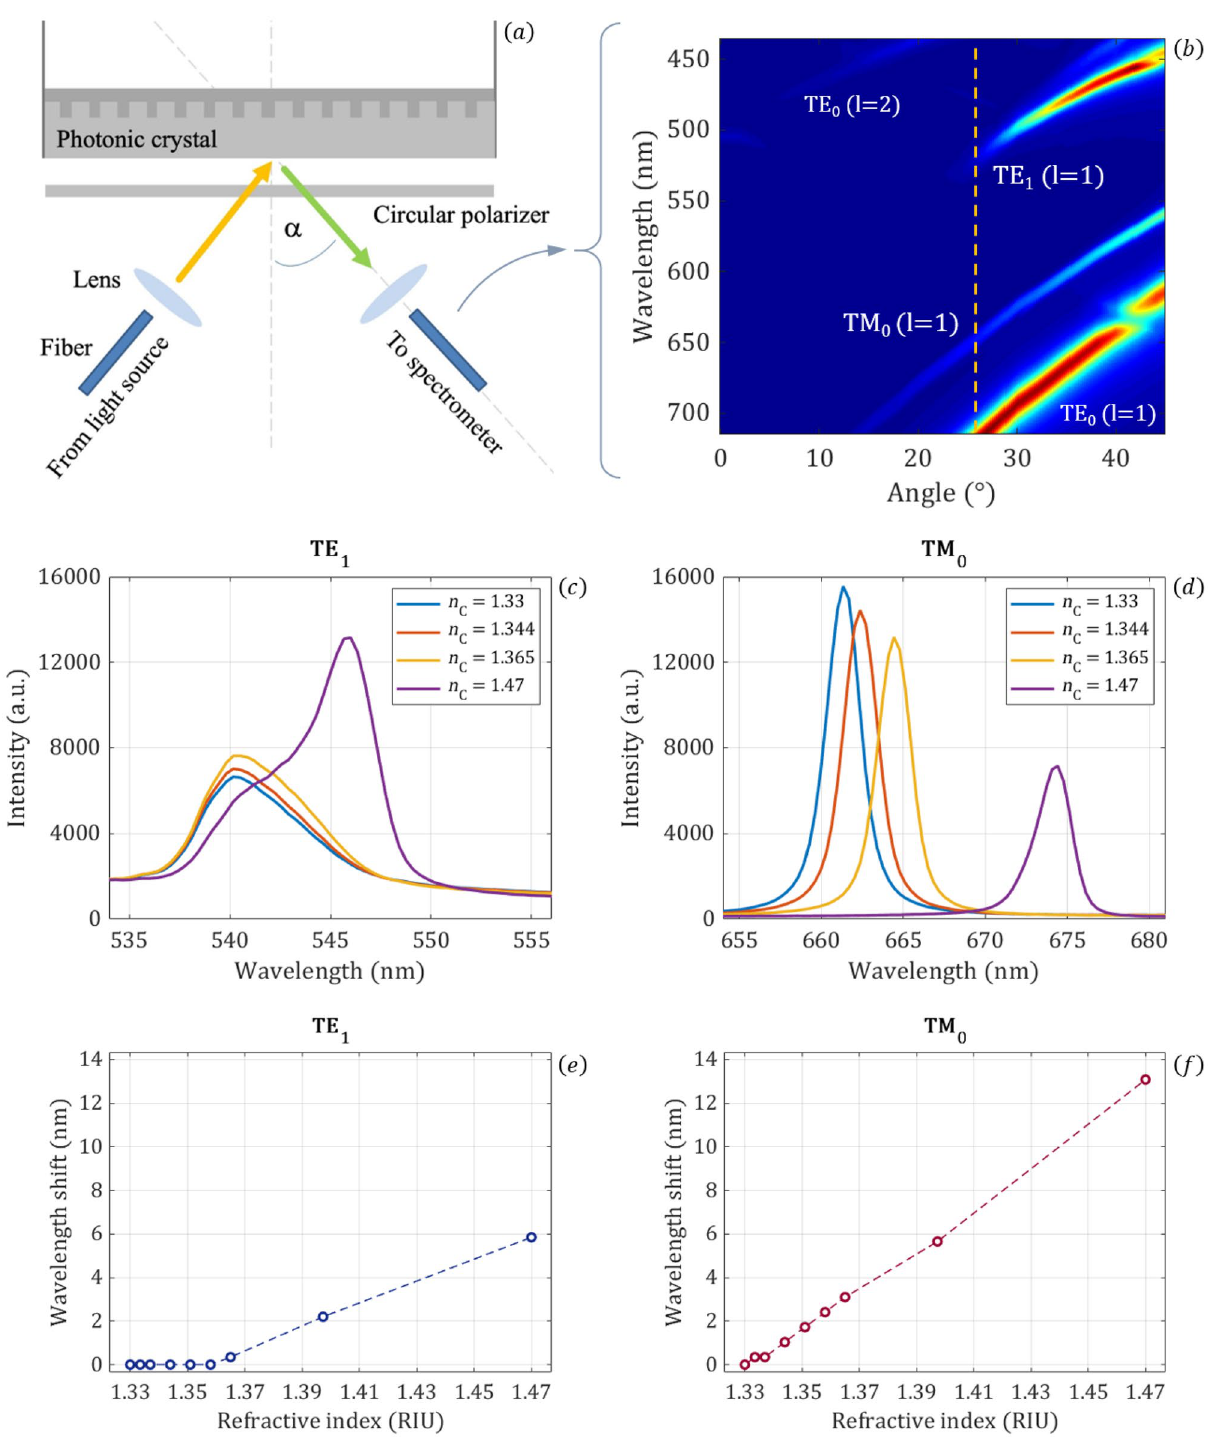
Figure 13. ( a ) Experimental setup for reflection measurements with grating waveguides with an incidence angle of 26°. ( b ) Intensity results as a function of incidence angle and wavelength (normalized to lamp spectrum and interpolated) for n c = 1.33. ( c ) Spectra of TE 1 mode near cut-off for four different refractive indices and ( d ) spectra of TM 0 more far-from cut-off. ( e ) Wavelength shift for the near cut-off TE 1 resonance and ( f ) far from cut-off results for the TM 0 mode for a refractive index